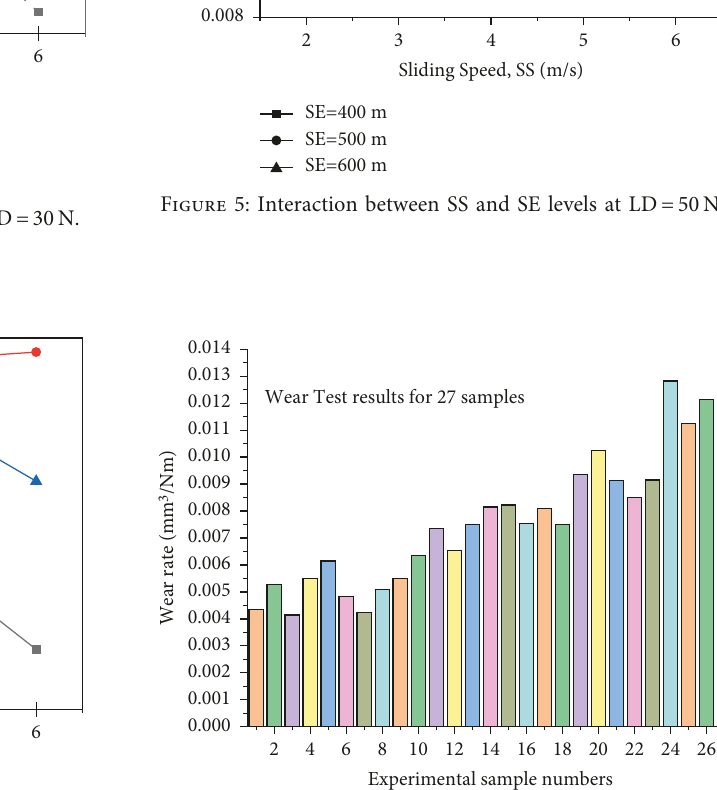
Figure 6: Wear test results for overall